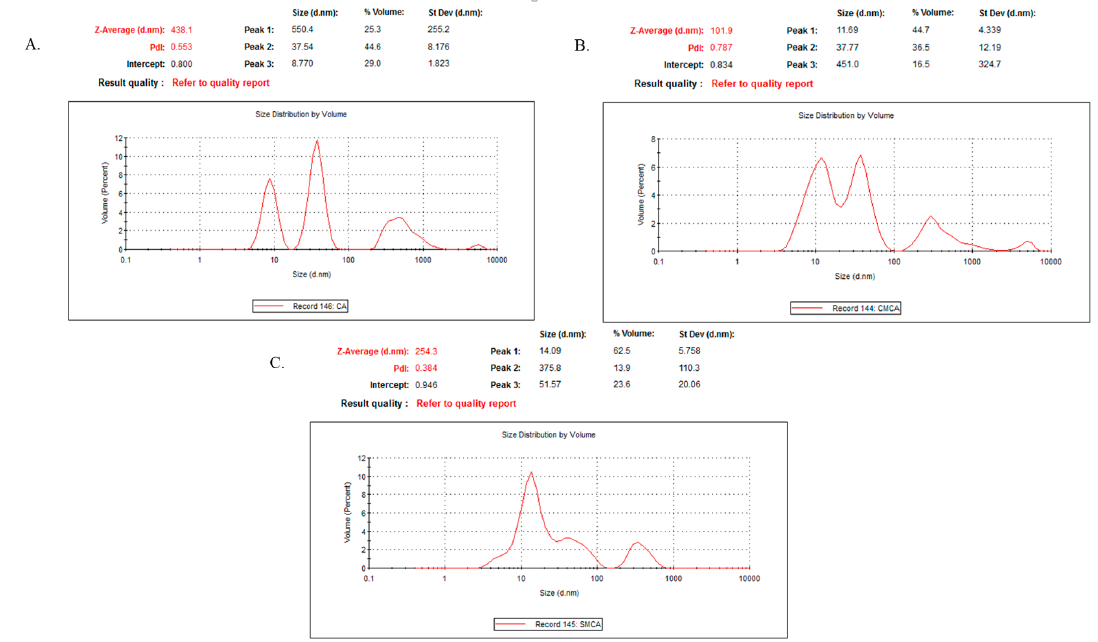
Figure 17. Particle size distributions determined by DLS (Dynamic light scattering). ( A ) DLS curve of CA NPs; ( B ) DLS curve of CMCA NPs. (C) , DLS curve of SMCA NPs.